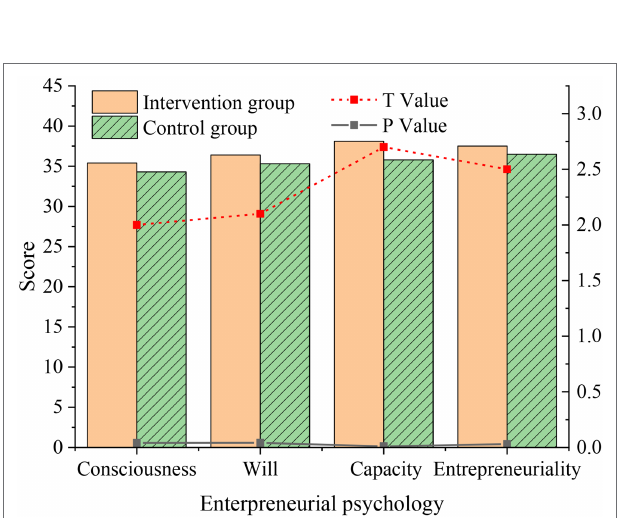
FIGURE 10 | Differences in the post-test level of entrepreneurial psychology between the intervention group and the control group.